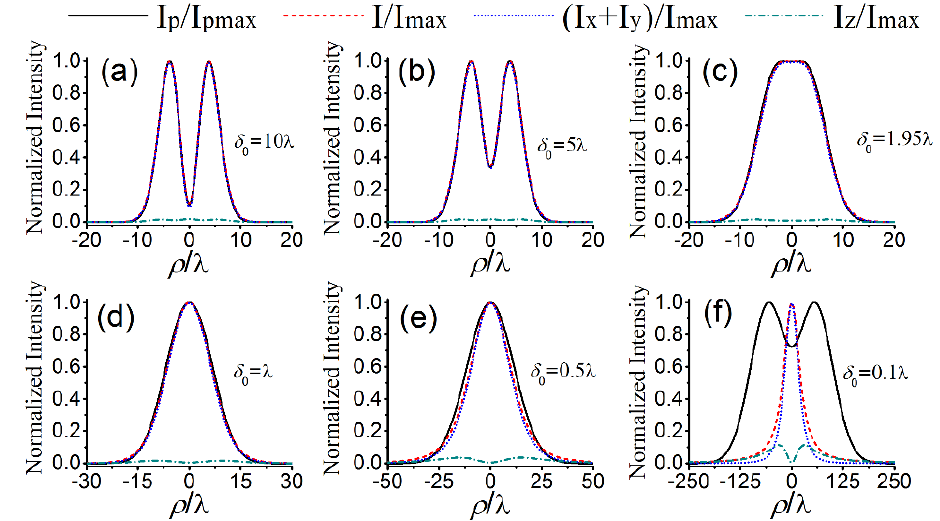
Figure 8. Normalized intensity (cross line at y = x ) I p /I p max , I/I max , (I x + I y )/I max , and I z /I max of a nonparaxial PCRP beam at z = 10 z R with ρ = 2 2 x y and σ 0 = λ for different values of the coherence widths. I p and I denote the total intensity for the paraxial and nonparaxial SCRP beam, respectively. I x + I y denotes the transverse intensity, while I z denotes the longitudinal intensity for the nonparaxial SCRP beam. The coherence widths are marked in the figure.